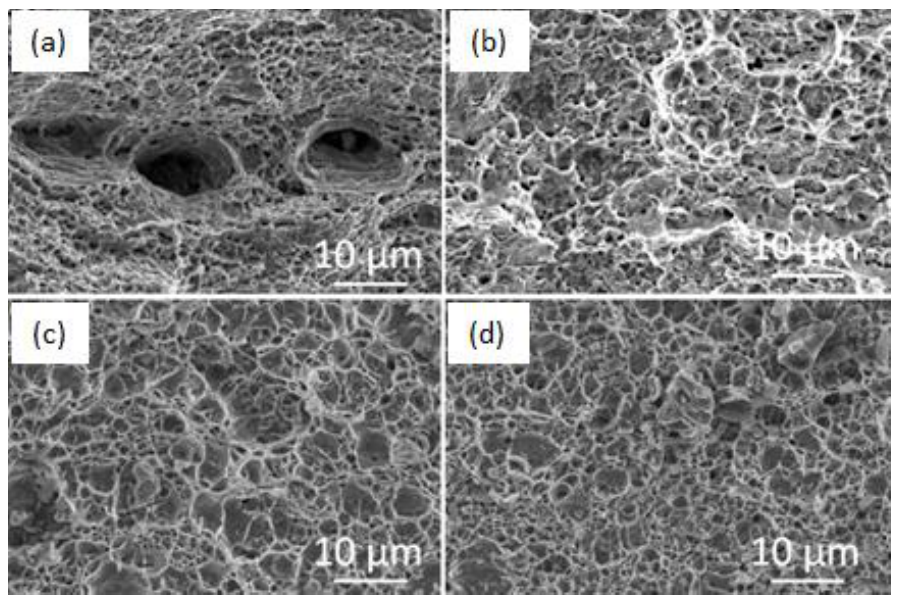
Figure 12. Representative SEM images of tensile fracture surfaces of the DP800-welded joints tested at deformation temperature of ( a ) −4 0 °C ( b ) 0 °C; DP1000-welded joints tested at deformation temperature of ( c ) −4 0 °C, and ( d ) 0 °C.